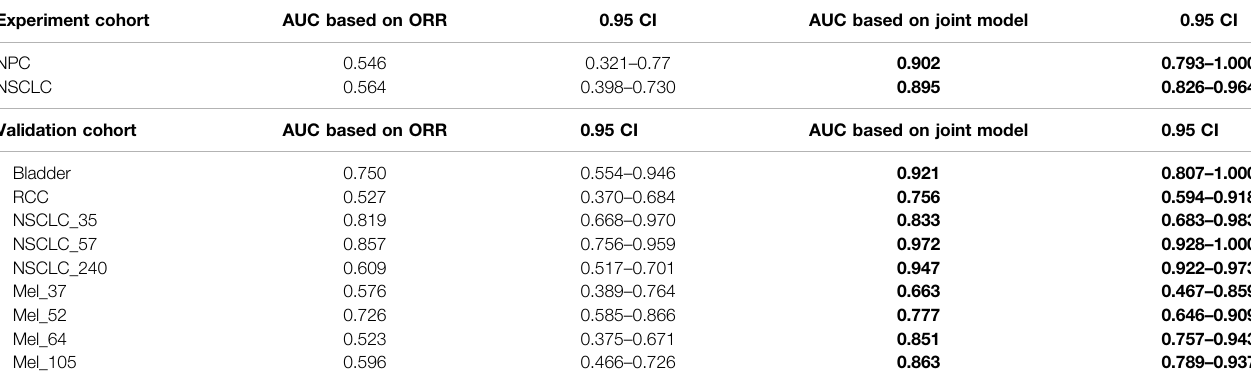
TABLE 4 | AUC comparison. The table reports the area under the curve (AUC), as well as the corresponding 0.95 con fi dence interval, for each metric (columns) applied to a different cancer cohort (rows). Bold-faced values indicate the best value for each cancer